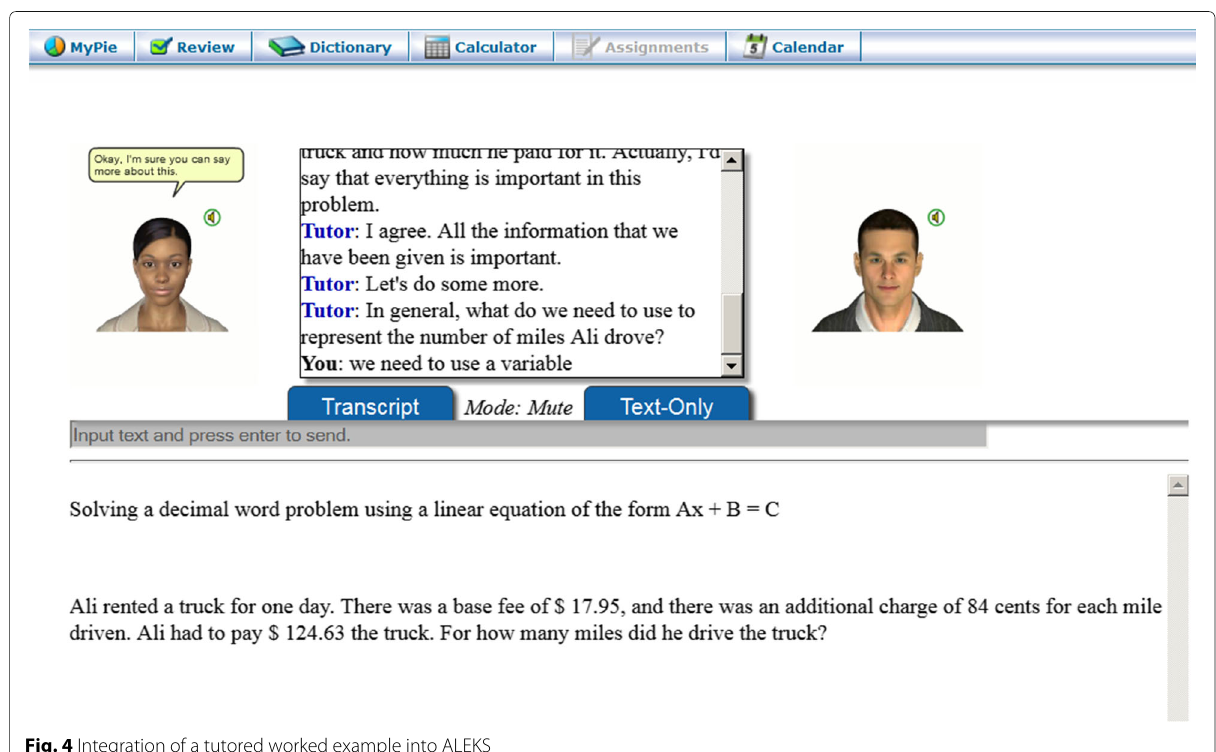
Fig. 4 Integration of a tutored worked example into